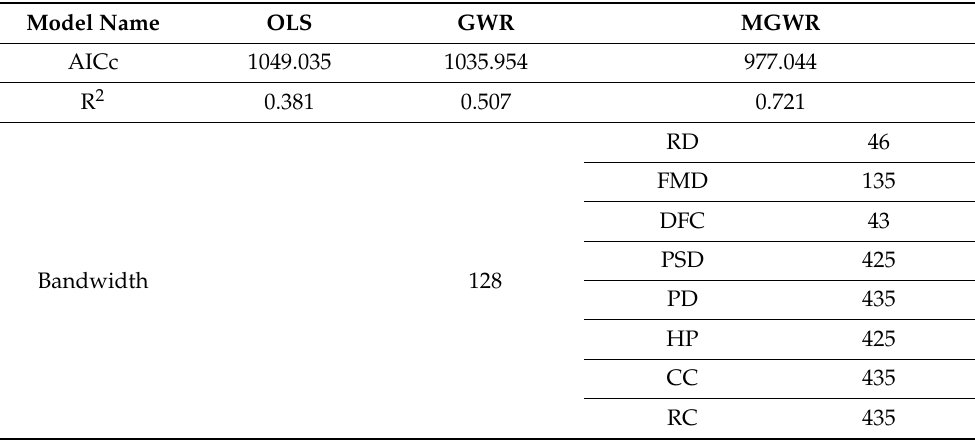
Table 6. Comparison of the model